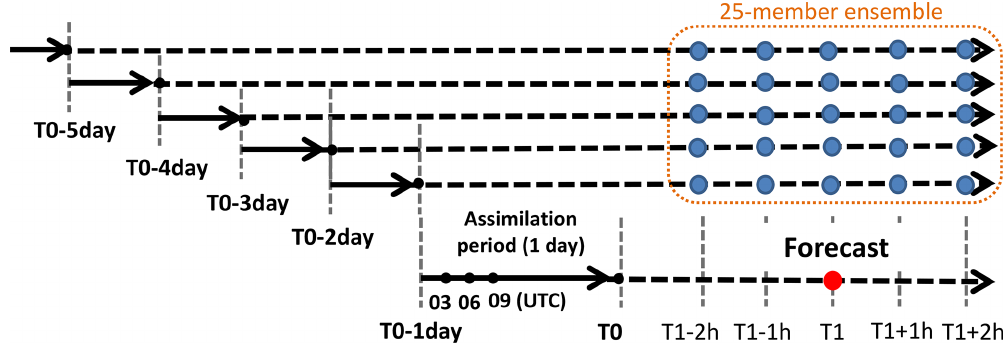
Figure 2. Forecast of aerosol transport model used for retrieval at time T 1 . Solid and dashed lines show the assimilation period (1d) and forecast run, respectively.